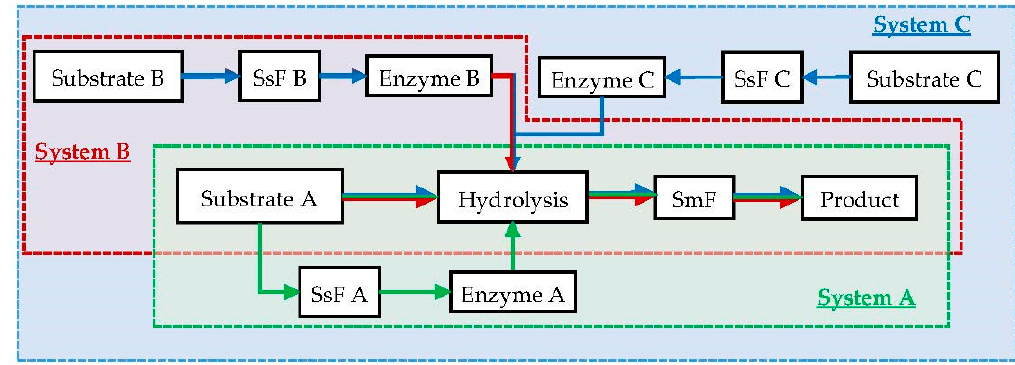
Figure 4. Diagram of different schemes for sequential SsF and SmF. The colour of the arrows indicates the system to which they belong (green for A, red for B and blue for C).